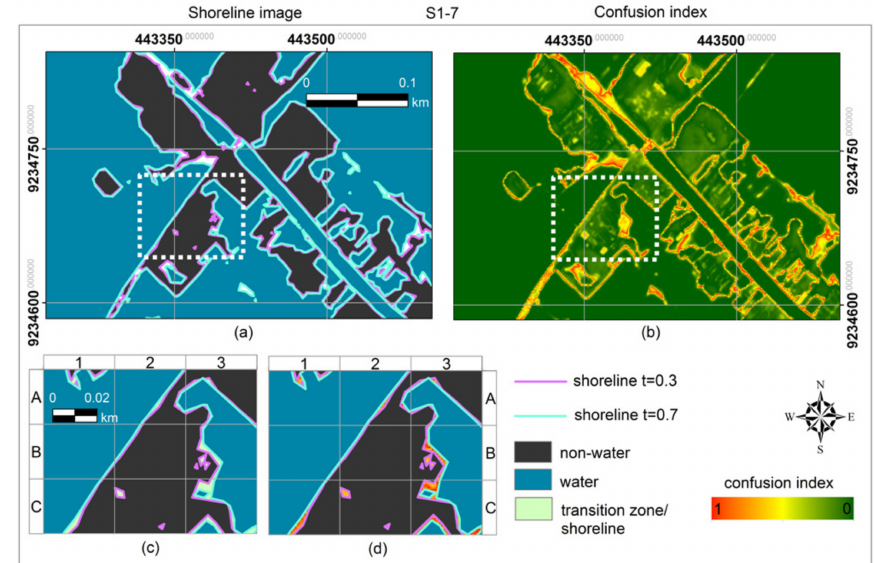
Figure 6. The shoreline as the transition zone between water and non-water ( a ); the fuzziness of the shoreline is represented by the confusion index denoting the uncertainty of pixels to be classified to the largest membership ( b ); zooming into the white-dashed rectangle sites ( c ); and shoreline image with fuzziness represented by the confusion index ( d ).